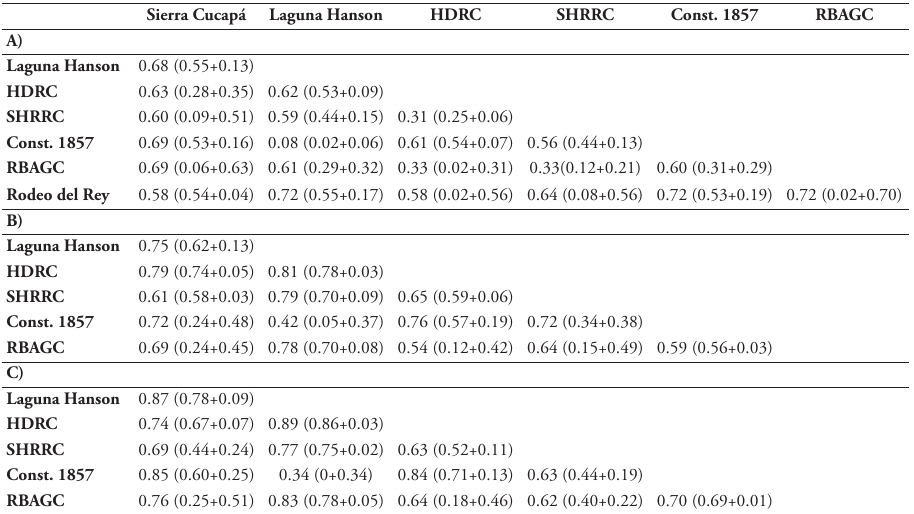
Table 3. Differences in species composition between pairs of sites. A birds B mammals C reptiles. The val- ues outside the parentheses correspond to the total difference in species composition ( β ), the first value jac inside the parentheses indicates the difference due to species turnover ( β ) and the second value indicates jtu the proportion due to nestedness ( β jne